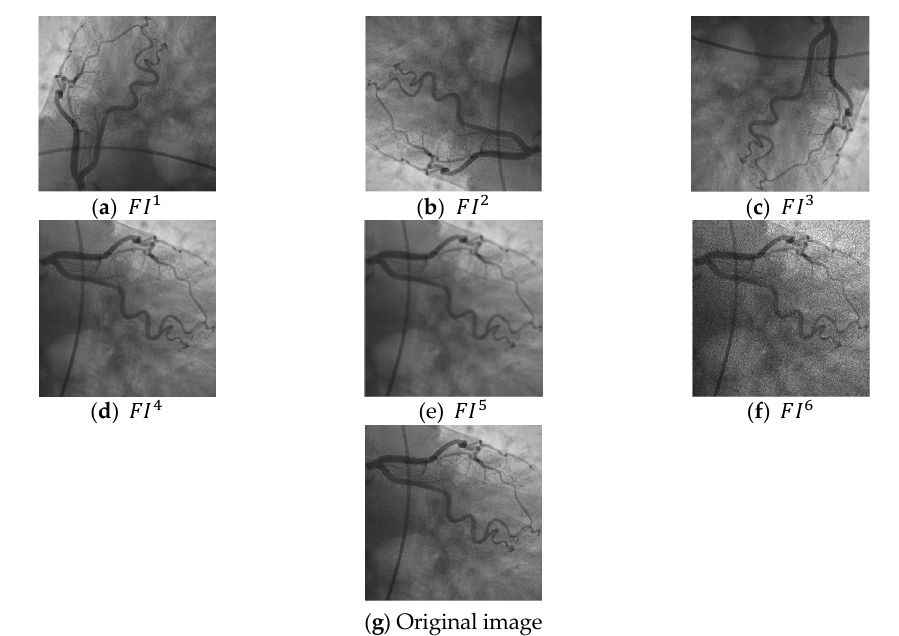
Figure 3. Sample filtered images and original images. ( a ) the first filtered image, ( b ) second filtered image, ( c ) third filtered image, ( d ) fourth filtered image, ( e ) fifth filtered image, ( f ) sixth filtered image, ( g ) the used original coronary angiography image.